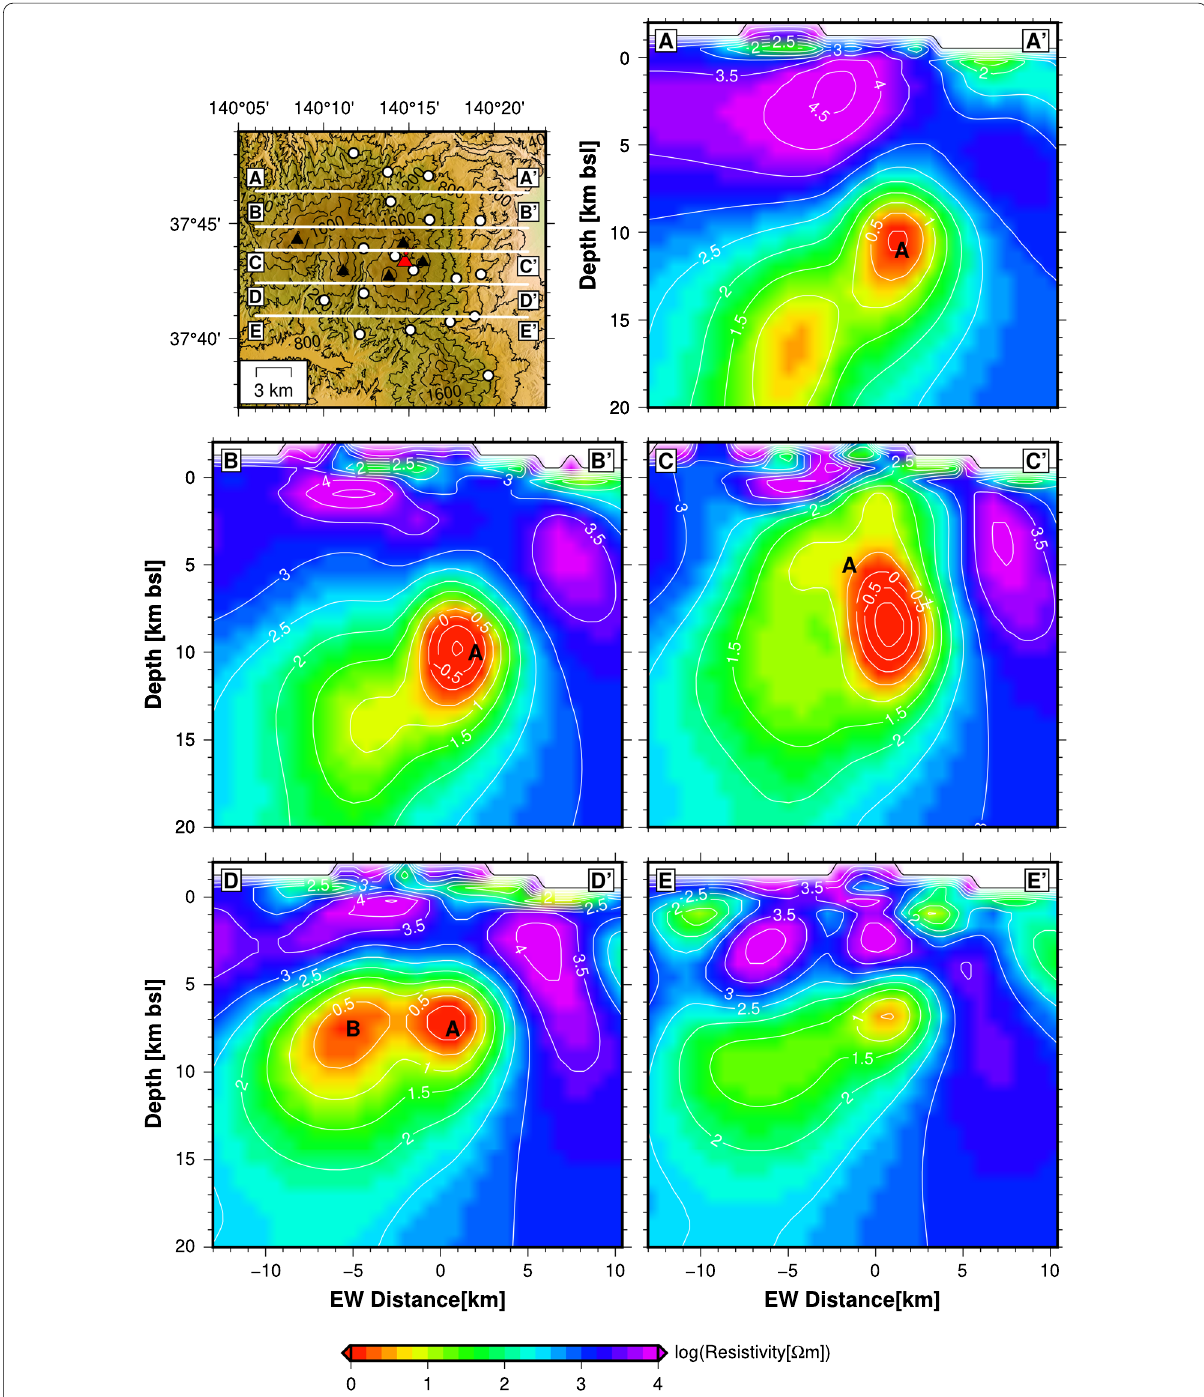
Fig. 6 Vertical profiles of the final resistivity model in the E–W direction. The top left figure shows the location of each vertical profile. The background colors are the same as in Fig. 5. The white lines are logarithmic resistivity contours. The origin of the E–W coordinate is fixed at Oana Crater. The labels A and B are printed on the same conductors of A, B in Fig.